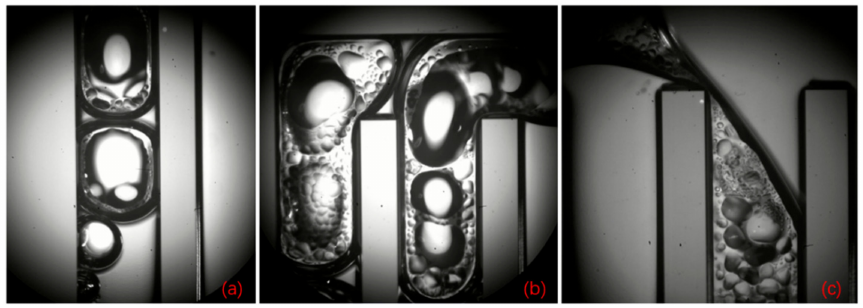
Figure 10. Condensation process in vapor phase pipeline.